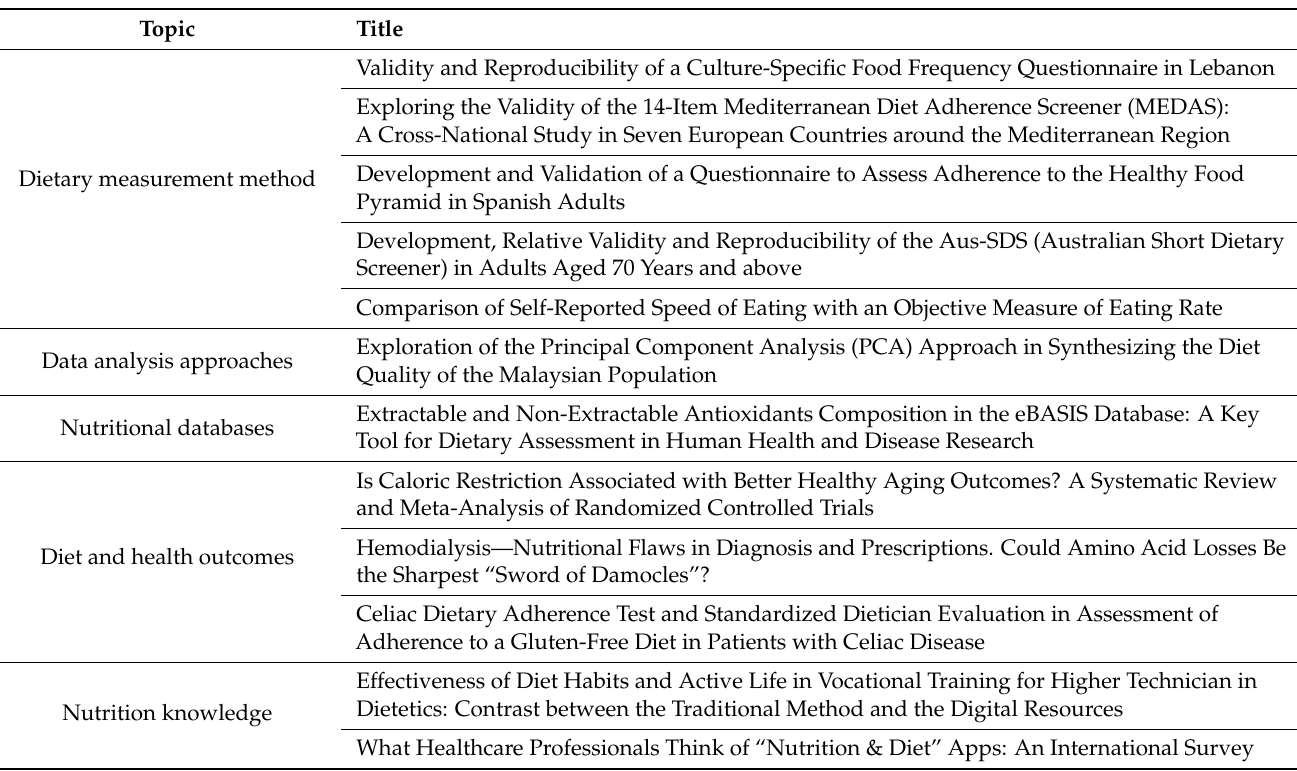
Table 1. Special issue “Dietary Assessment and Human Health and Disease” titles of